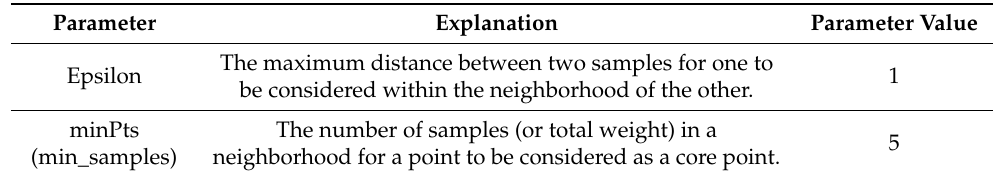
Table 3. Overview of DBSCAN parameters.